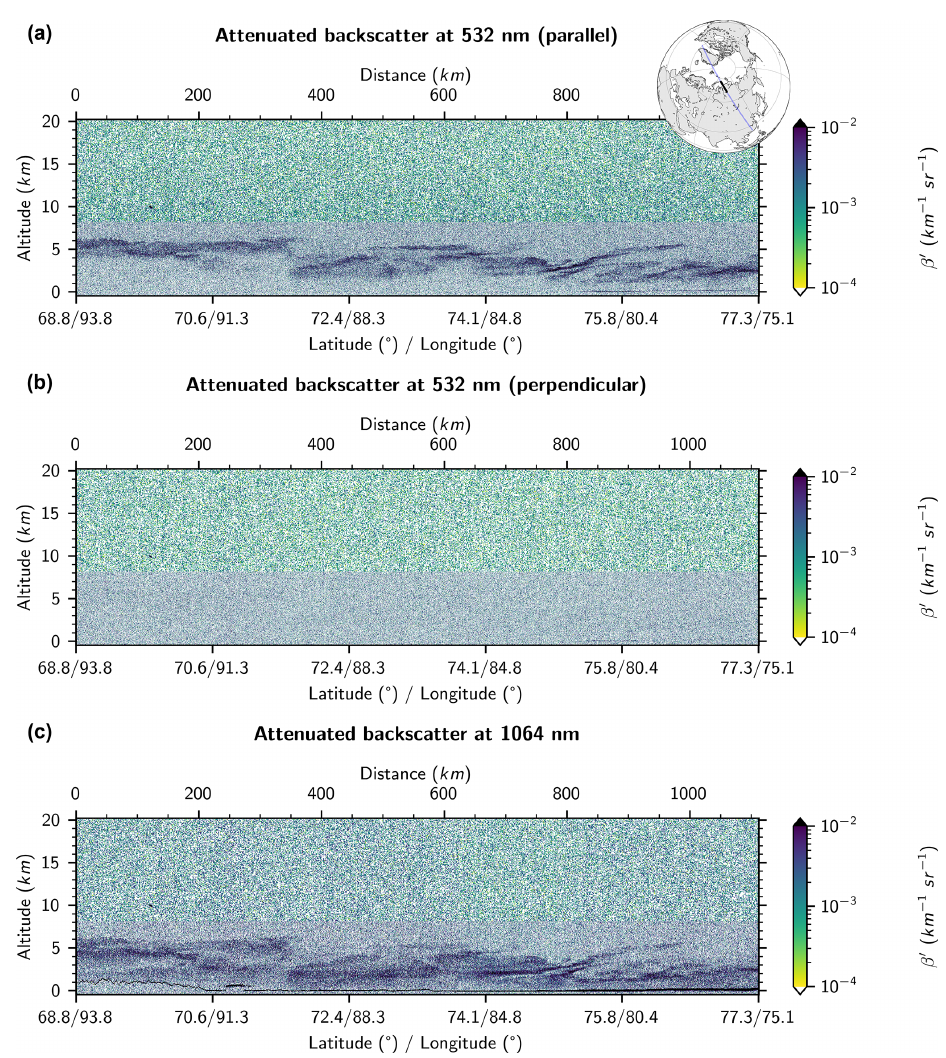
Figure 12. Curtain of attenuated scattering ratios measured by CALIOP during a dense smoke event which occurred in Siberia on 26 July 2006, 06:00:25UTC (start point), daytime observations at (a) 532nm parallel, (b) 532nm perpendicular and (c)